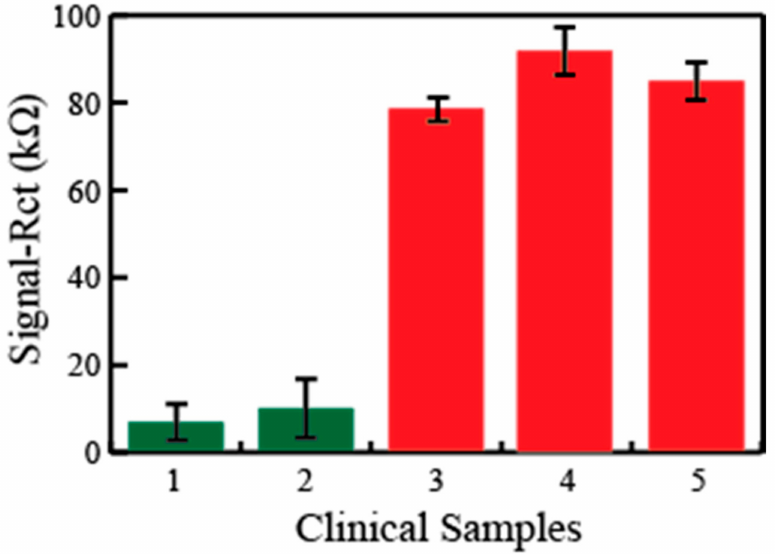
Figure 6. The testing of five clinical samples taken as three aliquots in each case and measuring the impedance on the sensor surface. The green bars indicate negative and red bars indicate the positive detection of the COVID-19 viral